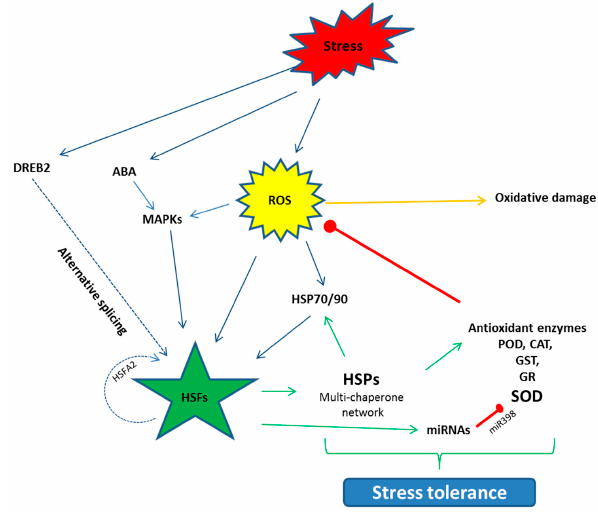
Figure 2. Schematic diagram of the activation of the HSFs and their interaction with the other pathways to counter stress situations. HSFs are activated directly or indirectly through the event of alternative splicing. HSFs further regulate the down-stream HSPs, antioxidant enzyme genes and miRNAs, which help the plants to develop stress tolerance. Arrows denote the positive while red bars stand for negative interaction. ROS (Reactive oxygen species), ABA (Abscisic acid), MAPK (Mitogen-activated Protein Kinase), DREB (Dehydration responsive element binding protein), POD (Peroxidase), CAT (Catalase), GST (Glutathione S transferase), GR (Glutathione reductase), SOD (Superoxide